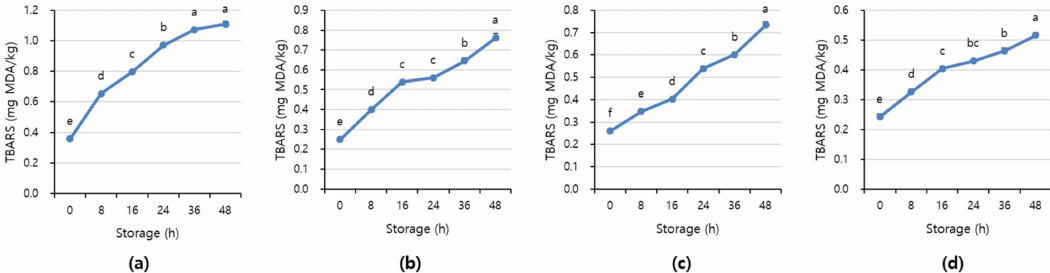
Figure 8. The TBARS value of ( a ) beef loin (quality grade 1+), ( b ) beef loin (quality grade 1), ( c ) beef round (quality grade 1+), and ( d ) beef round (quality grade 1) over the storage periods at room temperature (23 ◦ C). a–f Different superscript letters above bars indicate a significant difference at p <